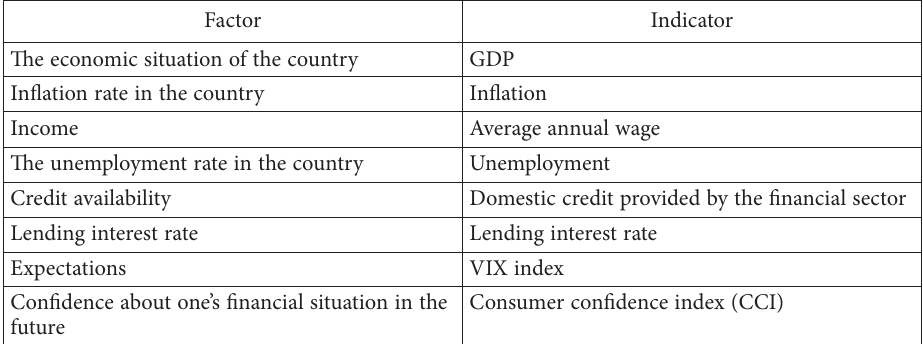
Table 1. Factors influencing people’s financial decisions and indicators expressing (source: created by authors based on Azbainis, 2013; Allen & Gale, 2007; Frankel & Saravelos, 2012; Hahm &